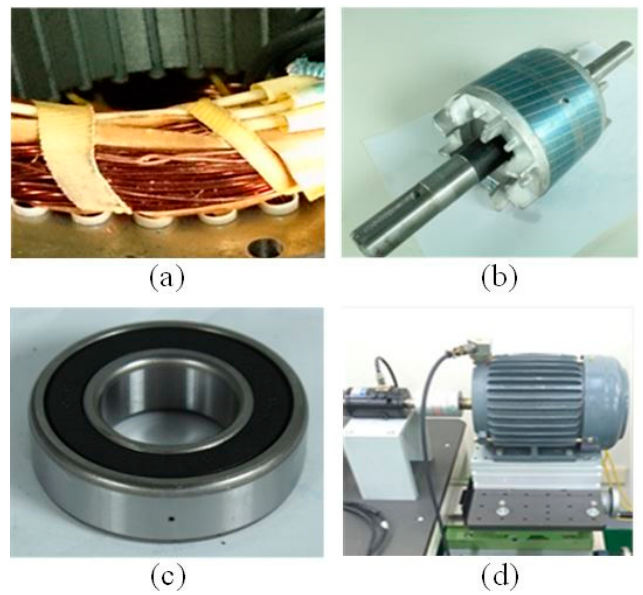
Figure 6. Four experimental models: ( a ) Stator fault, ( b ) rotor fault, ( c ) bearing fault, ( d ) misalignment fault.